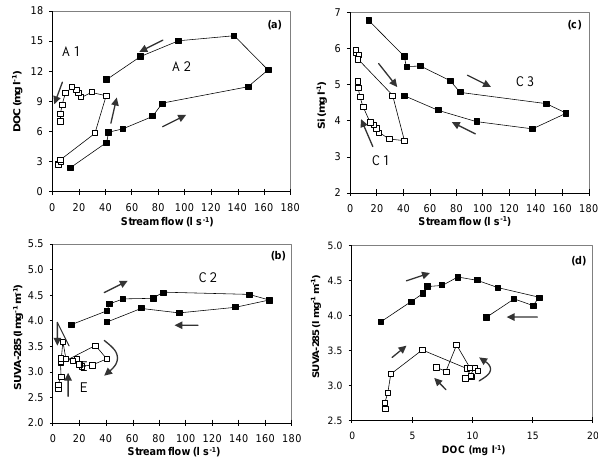
29 Fig. 4. Hysteresis in (a–c) solute properties against stream flow and Figure 4. Hysteresis in (a-c) solute properties against stream flow and (d) SUVA 30 against DOC concentration for the Aug-05 (white squares) and Nov-06 storms (black 31 (d) SUVA against DOC concentration for the August-2005 (white squares). Arrows indicate the direction of hysteresis for storm data and curves are 32 squares) and November-2006 storms (black squares). Arrows indi- classified according to the scheme in Table 2. 33 cate the direction of hysteresis for storm data and curves are classi- fied according to the scheme in Table